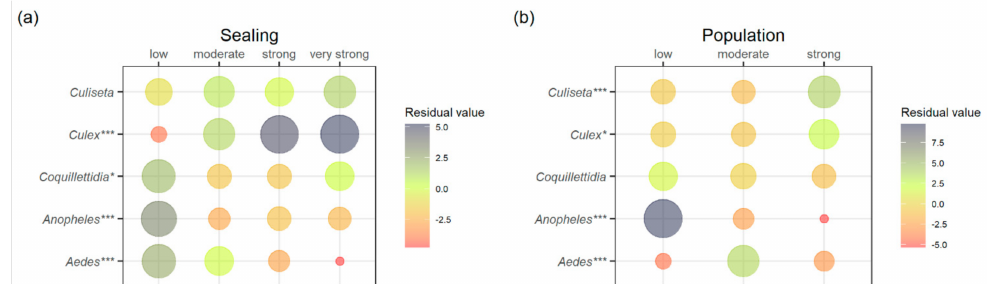
Figure 4. Tendencies of genera for a certain level of urbanization categorized by the indicators soil sealing ( a ) and human population density ( b ) by means of Pearson residuals. Dot size corresponds to the overall contribution to the total Chi-square value. Positive scores indicate an attraction (green to blue) and negative scores indicate a repulsion between rows and columns (yellow to red). Significant differences from row-wise comparisons are indicated (* = p < 0.05, *** = p <